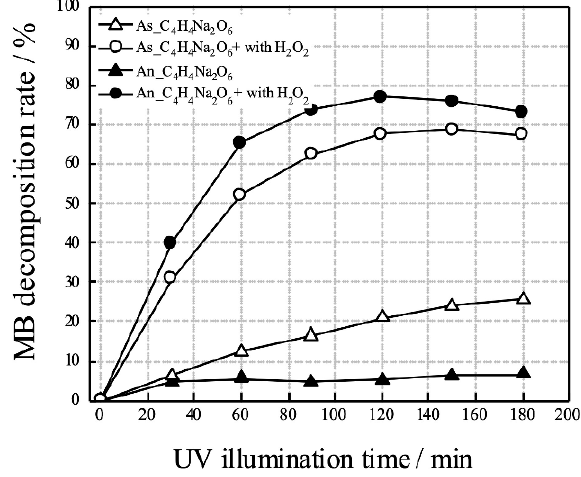
Figure 12. Degradation rate of MB against UV illumination time for anodized TiNbSn alloy prepared in sodium tartrate. Plots of the degradation rate of MB against UV illumination time for the as-anodized and annealed anodic oxides prepared in sodium tartrate electrolyte with or without H 2 O 2 on the TiNbSn alloy. MB: Methylene blue.